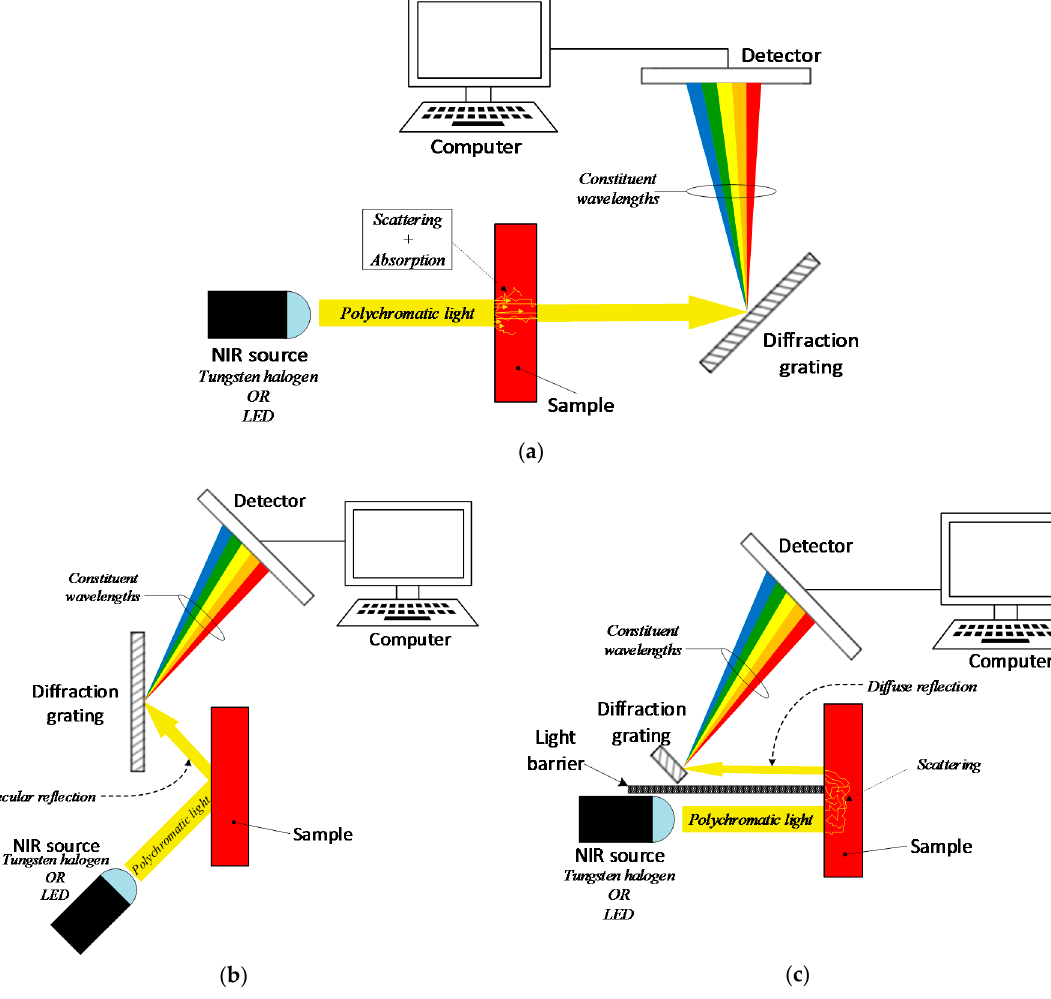
Figure 9. Schematic representation of the three modes of NIR spectroscopy. ( a ) Transmittance mode. ( b ) Reflectance mode. ( c ) Interactance mode. Table 9. Advantages and disadvantages of NIR spectroscopy.